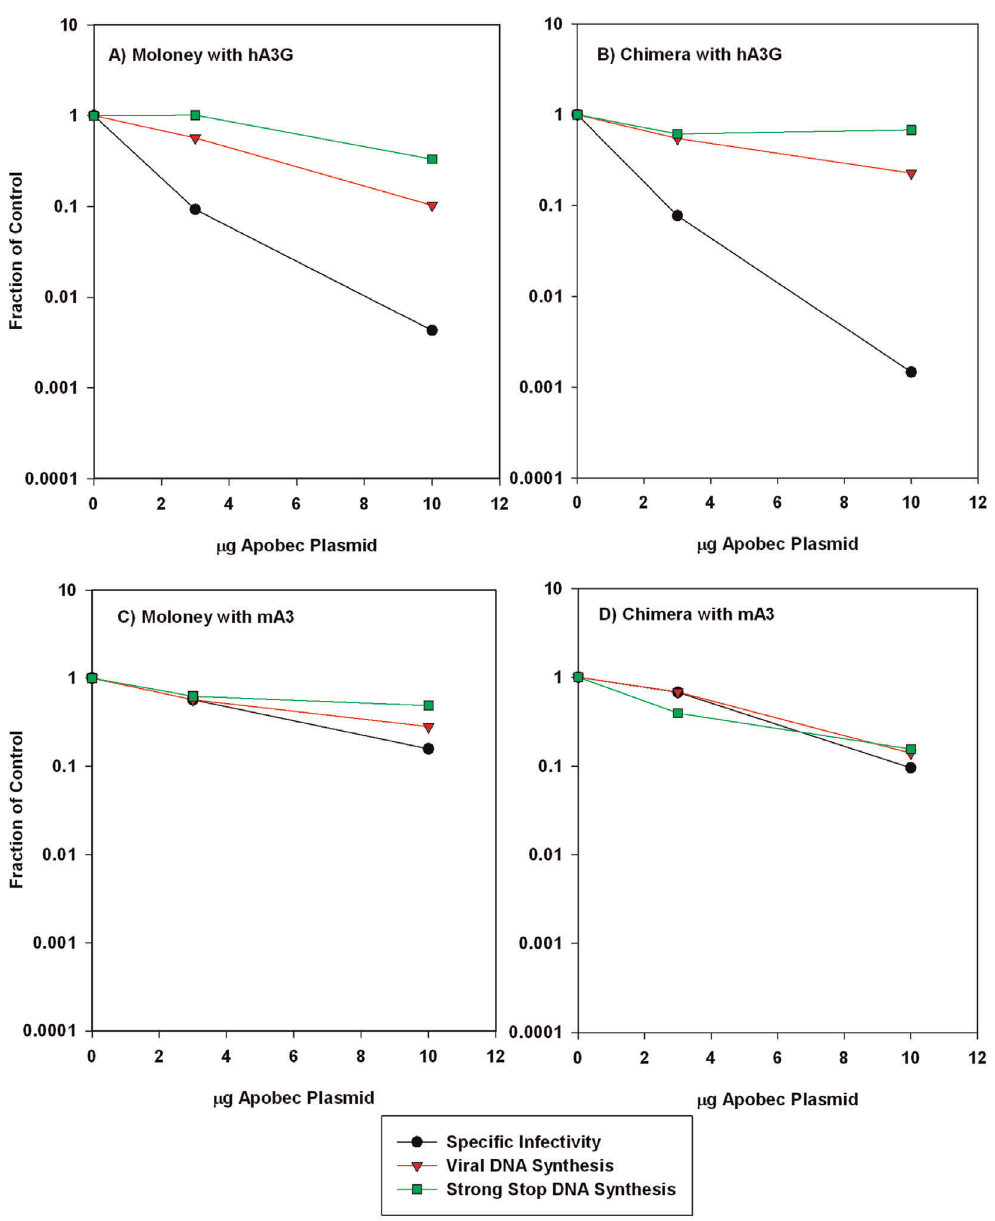
Figure 4. Comparison of the infectivity of the viruses with the synthesis of the viral DNA. Viruses were prepared by co-transfection of 293T-hygro cells (which contain pLXSH) with viral clones, pBABE-Luc, and 0, 3, or 10 m g of APOBEC3 DNA. 293-mCAT1 cells were then infected with the resulting culture fluids. Relative specific infectivities (black lines) were determined as in Fig. 2. Parallel cultures were lysed and assayed for hph DNA (red lines) and strong stop DNA (green lines) as described in Materials and Methods. Values in each assay were divided by the value for the virus produced with no APOBEC3 plasmid.